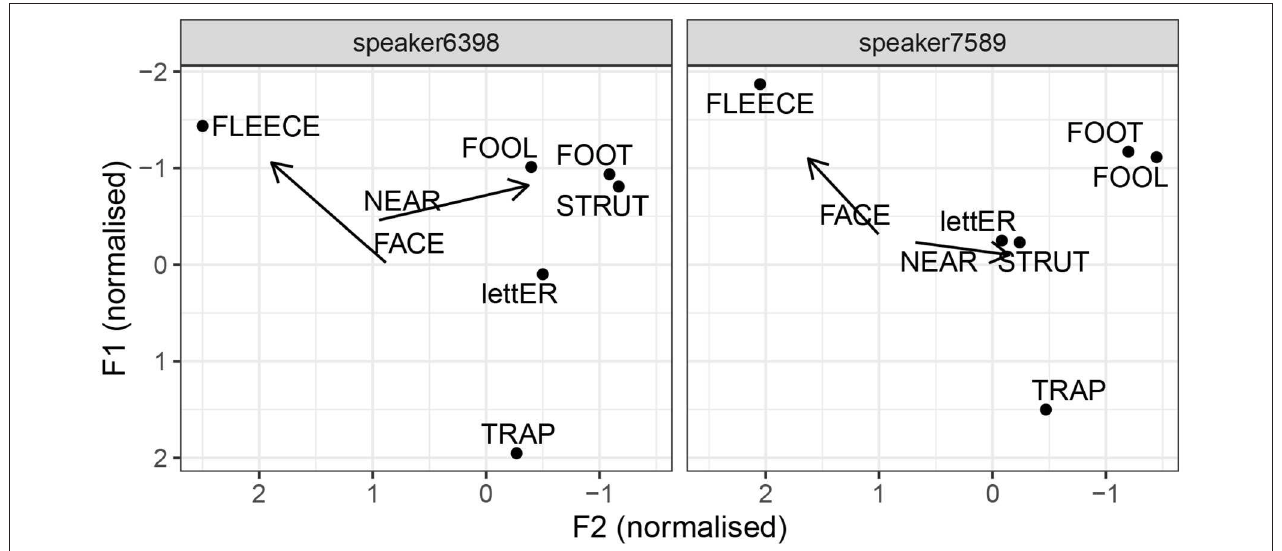
FIGURE 8 | Selected vowels by two Manchester